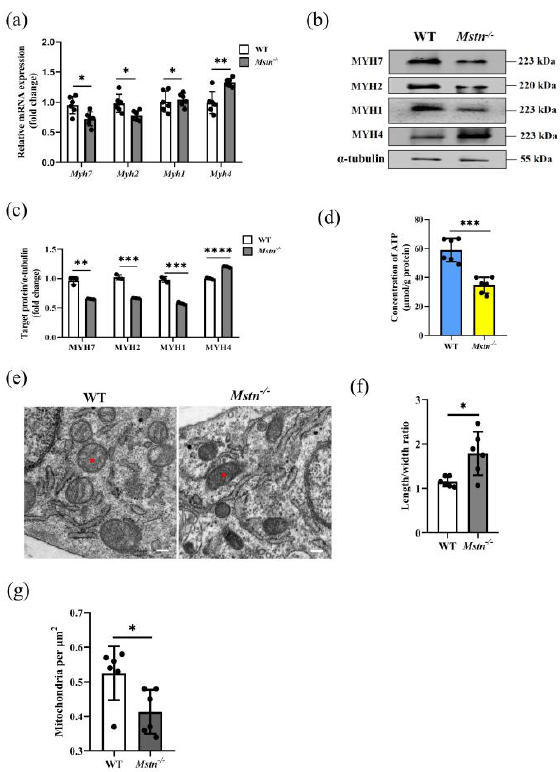
Figure 2. The type of muscle energy metabolism is changed in Mstn − / − mice. ( a ) Expression of mRNA for myosin heavy chain in quadriceps. ( b ) Expression of protein for myosin heavy chain in quadriceps. ( c ) The quadriceps proteins of 6 WT mice and Mstn − / − mice were collected and analyzed quantitatively in triplicate Each dot presents a repeat. ( d ) The total ATP in the WT and Mstn − / − mice quadriceps. ( e ) Transmission electron microscopy (TEM) of muscle cell mitochondria from WT (left) and Mstn − / − mice (Right). The red stars present the location of the mitochondria. Scale bars, 100 nm. ( f ) Quantification of TEM: the ratio of mitochondrial length to width from ( e ). ( g ) Quantification of TEM mitochondria: the number of mitochondria per µ m 2 from ( e ). Data presented as mean ± SD. Compared with the control group, * p < 0.05, ** p < 0.01, *** p < 0.001, **** p < 0.0001; Student’s t -tests were used to calculate the p -values. We used n = 6 mice per group. Except where noted, each dot represents a